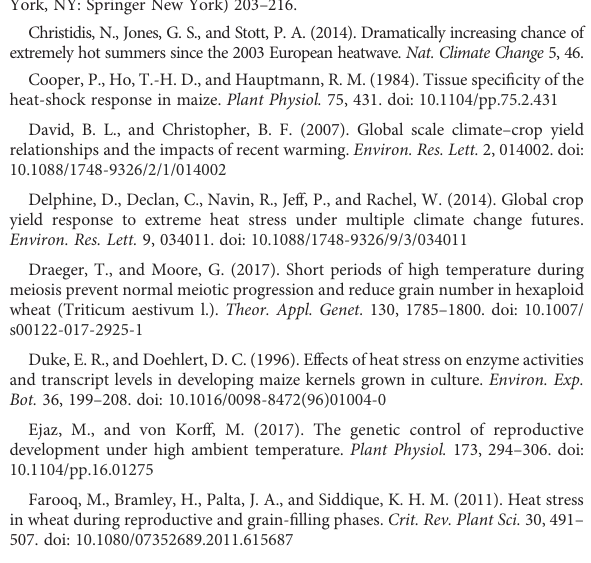
SUPPLEMENTARY FIGURE 4 Immunolabelling of cell wall components in anthers and ovules in Optic. Comparison of control and heat stressed anthers and ovules in barley fl orets of the variety RGT Planet. Antibodies include BG1 (1,3;1,4- b - glucan, green) and LM19 (low methylesteri fi ed pectin, red). Calco fl uor White counterstain was used to detect cellulose and mixed-linkage glucan (blue).